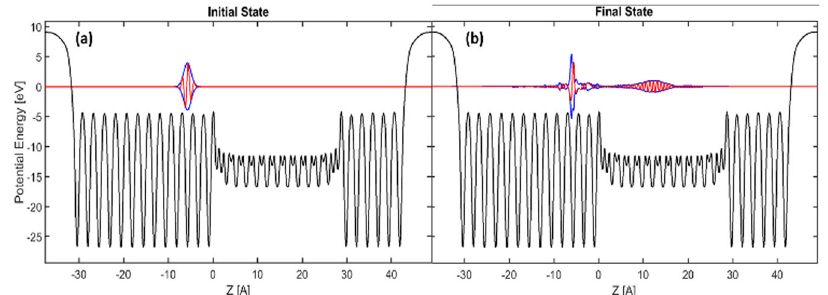
Fig. 6 Charge transport across a JJ. The black curve is the potential curve, and the red and blue curves are the real and absolute value of the wavefunction. a Initial state. b Final state after reaching a halt.